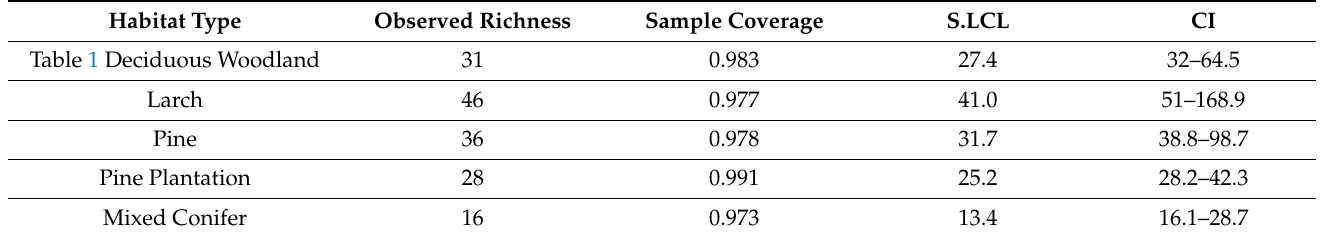
Table 3. Bird richness in areas with different forest habitats in Khentii Mountains.